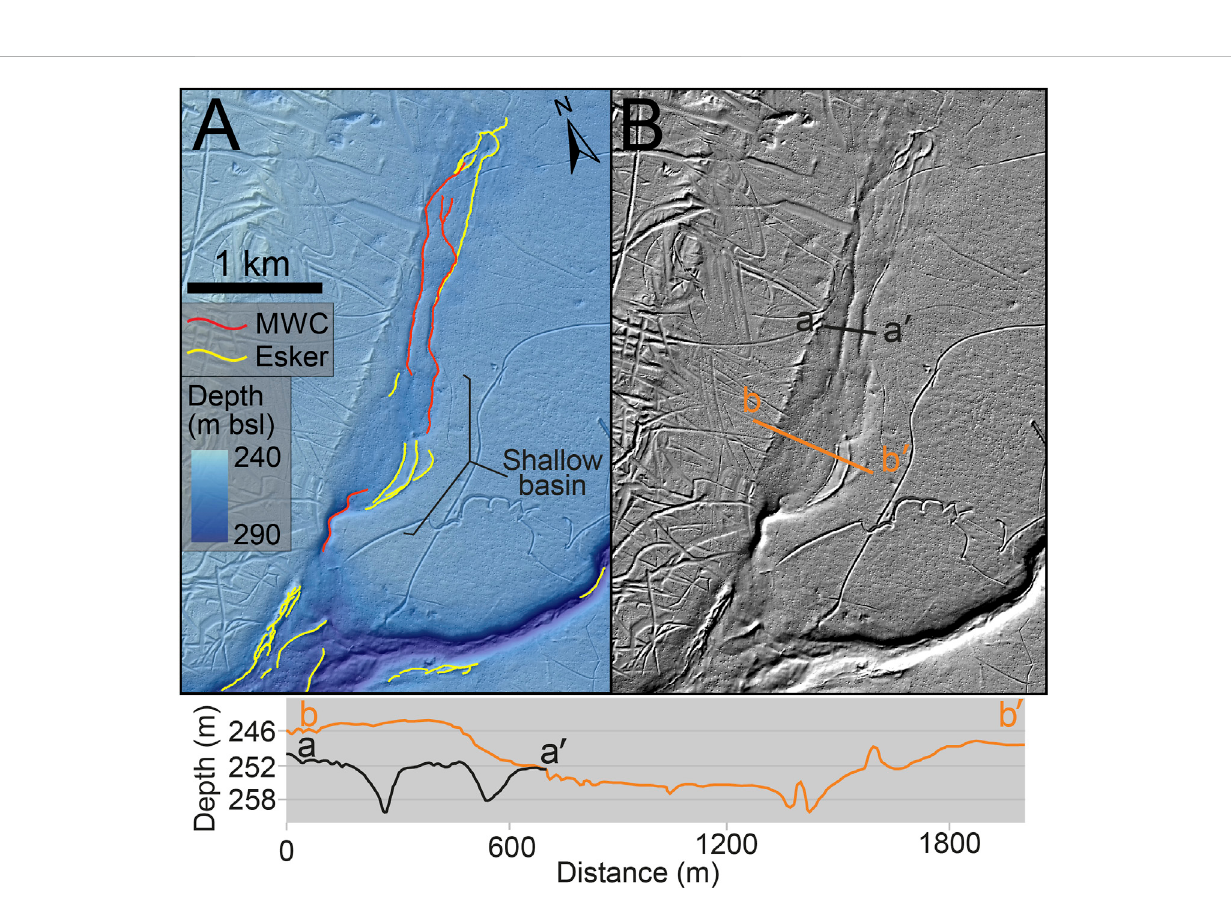
FIGURE 6 Site4: (A) Meltwaterlandformsattheupstreamendofatunnelvalley. (B) Hillshademapandpro fi lesacrosstwoparallelchannels(a-a´)andashallow basin with esker ridges along the eastern bank (b-b´). MWC = meltwater